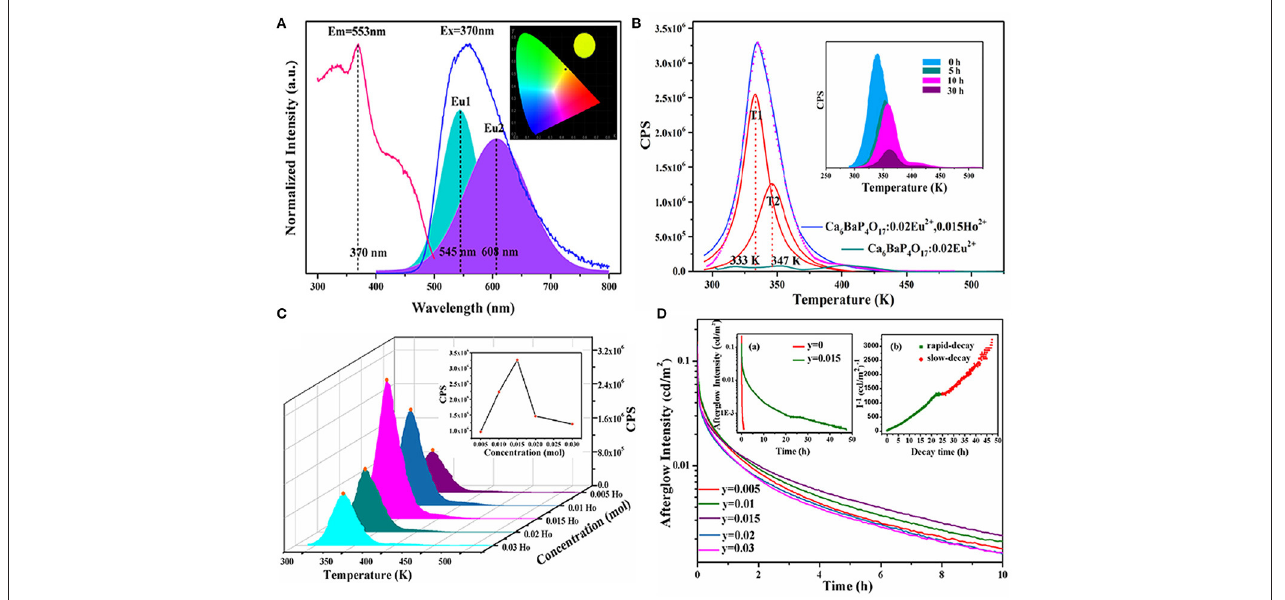
FIGURE 2 | (A) PLE and PL spectra of Ca 6 BaP 4 O 17 : 0.02Eu 2 + , 0.015Ho 3 + . Inset: CIE chromaticity diagram for Ca 6 BaP 4 O 17 : 0.02Eu 2 + , 0.015Ho 3 + excited by 370nm. (B) TL curves of Ca 6 BaP 4 O 17 : 0.02Eu 2 + , 0.015Ho 3 + and Ca 6 BaP 4 O 17 : 0.02Eu 2 + excited for 2min. Inset: TL curves of Ca 6 BaP 4 O 17 : 0.02Eu 2 + , 0.015Ho 3 + excited for 2min and placed in a dark room for different times. (C) TL curves of Ca 6 BaP 4 O 17 : 0.02Eu 2 + , yHo 3 + (0.005 ≤ y ≤ 0.03) excited for 2min. (D) LPL decay curves of Ca 6 BaP 4 O 17 : 0.02Eu 2 + , yHo 3 + (0.005 ≤ y ≤ 0.03). Inset show the LPL decay curves of Ca 6 BaP 4 O 17 : 0.02Eu 2 + and Ca 6 BaP 4 O 17 : 0.02Eu 2 + , 0.015Ho 3 + and the function of reciprocal afterglow intensity ( I − 1 ) vs. time ( t ) of Ca 6 BaP 4 O 17 : 0.02Eu 2 + , 0.015Ho 3 + excited for 15min. Reproduced by permission of The rOyal Society of Chemistry.